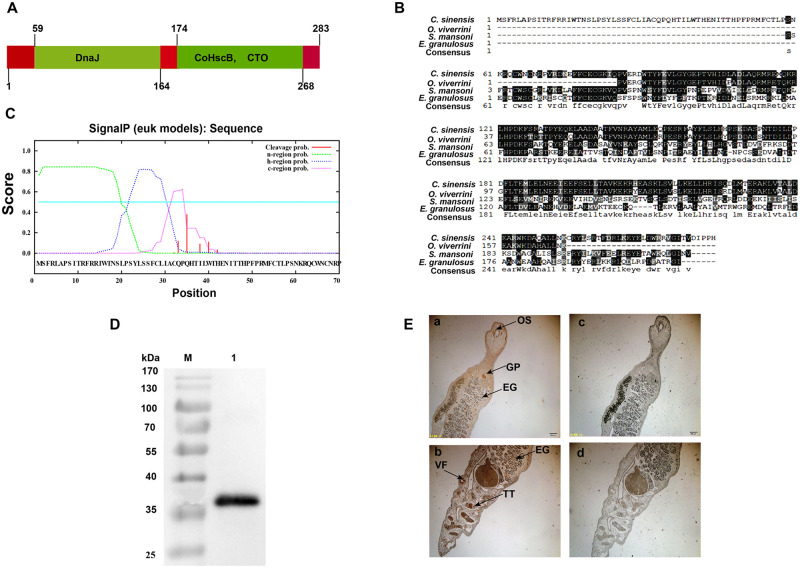
Identification, characterization, and immunogenicity of Clonorchis sinensisHscB.(A) Secondary structure of CsHscB including three domains: DnaJ, Co-chaperone HscB (CoHscB), and C-terminal oligomerisation (CTO). (B) Multiple protein sequences alignment of CsHscB among different species of the helminthes. (C) Signal peptide identification of CsHscB using SignalP server 3.0. (D) Western-blot analysis of purified rCsHscB using an anti-His antibody. (E) Expression and distribution of rCsHscB in the C. sinensis adult worms using IHC. a~b:rCsHscB on the worm bodies were detected using the primary antibody of rCsHscB; c~d: rCsHscB on the worm bodies were detected using IgG isotype as the primary antibody for controls. Arrows indicate the expression of rCsHscB mainly on the oral sucker (OS), vitelline follicles (VF), genital pore (GP), testis (TT), and eggs (EG). Scale bars, 20 μm.